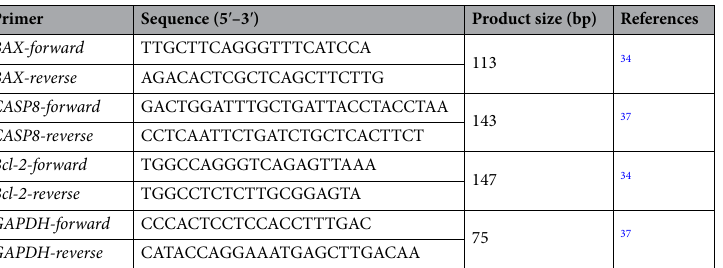
Table 1. Sequence of the primers used in this study (The efficiency of primers was provided in supplementary mide (MTT) assay 18 . For culture maintenance, the cells were cultured on standard Dulbecco’s modified Eagle’s